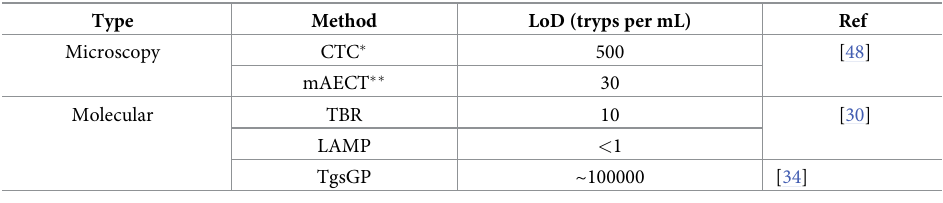
Table 6. Comparison of LoD between different diagnostic